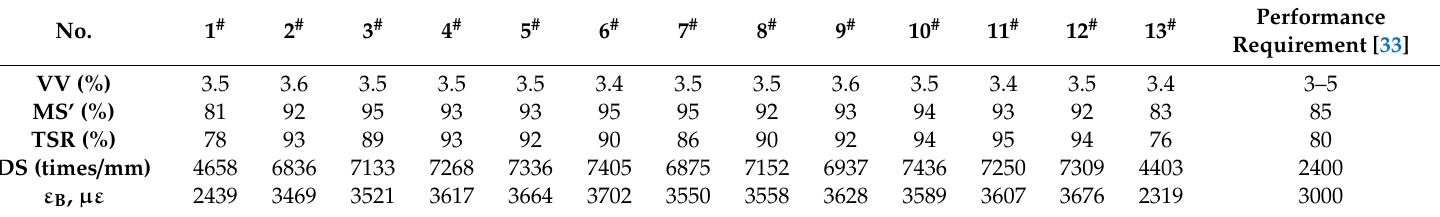
Table 6. Performances of modified bituminous mixtures by direct-to-plant